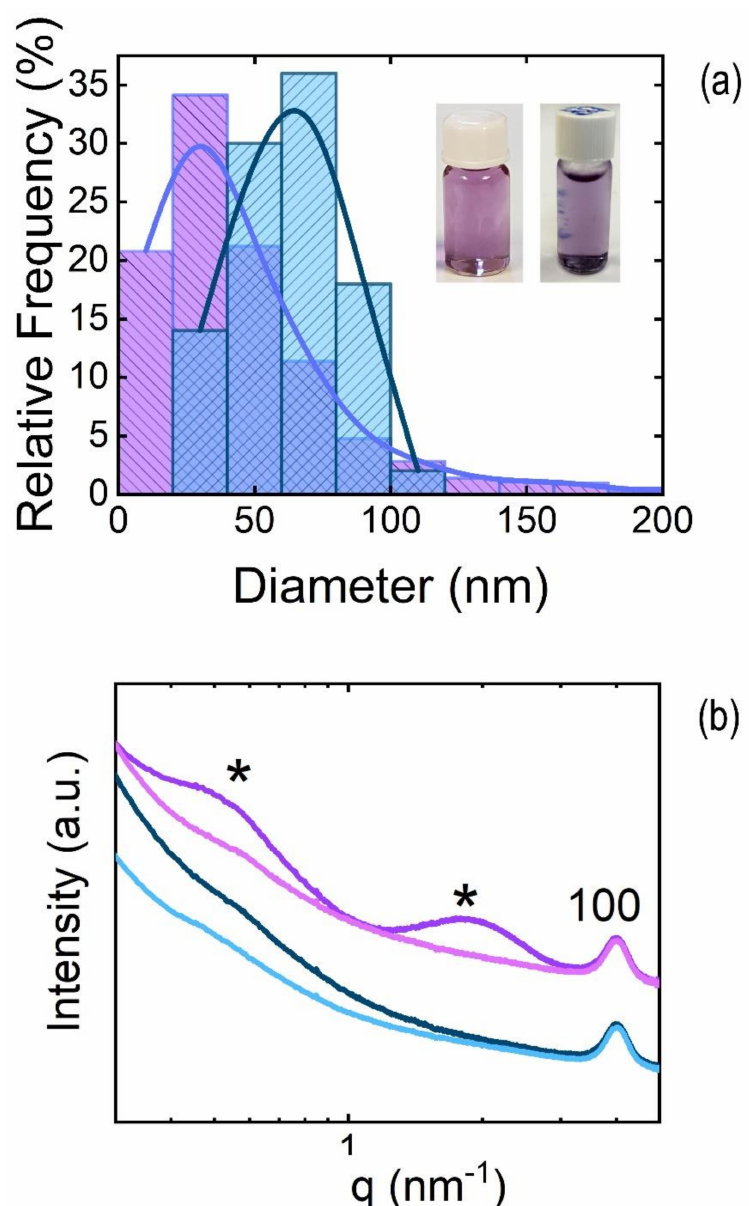
Figure 4. ( a ) Particle diameter histogram from P3HT particles prepared by miniemulsion using two different concentrations of sodium dodecyl sulfate (SDS), i.e., 0.1% in weight (blue bars) and 1% in weight (purple bars). Images of the inks prepared by the two concentrations are shown in the inset. Ink prepared using 1% wt. SDS concentration (left bottle) and 0.1% wt. SDS concentration (right bottle); ( b ) SAXS from the inks before (darker curves) and after dialysis (lighter curves). 1% wt. SDS purple curves and 0.1% wt. SDS blue curves. Asterisks mark the features corresponding to the SAXS curves of SDS